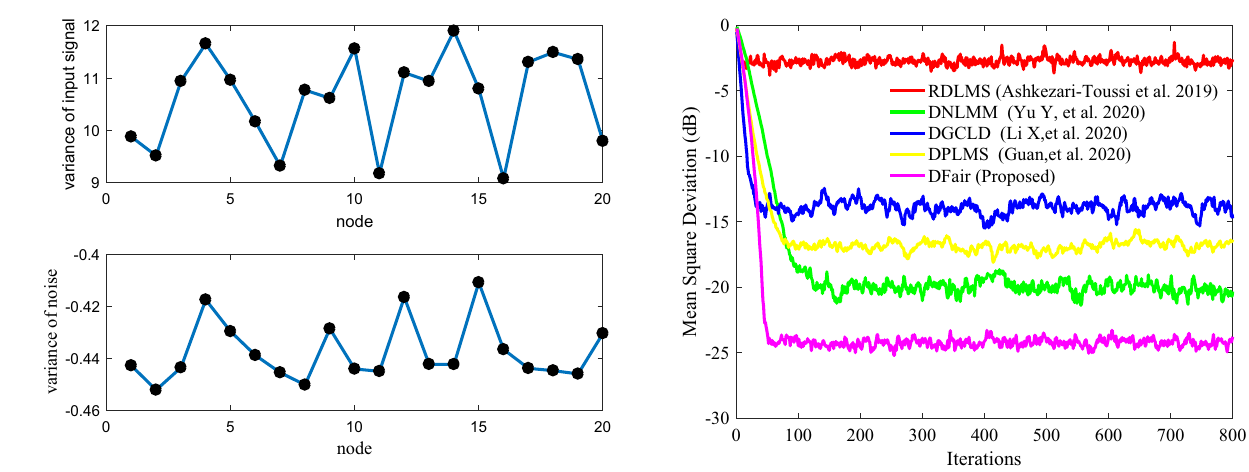
Figure 8. (Left_top) the input signals { X n ( i ) } variances of at each network node with 2 R ( t ) I M , t = 1, 2, 3, . . . , M , (Left_bottom) the measurement interference variances ε n ( i ) at each xx , n = σ x , n network node; (Right) Transient network MSD (dB) iteration curves of the RDLMS, DNLMM, DGCLD, DPLMS, and DFair